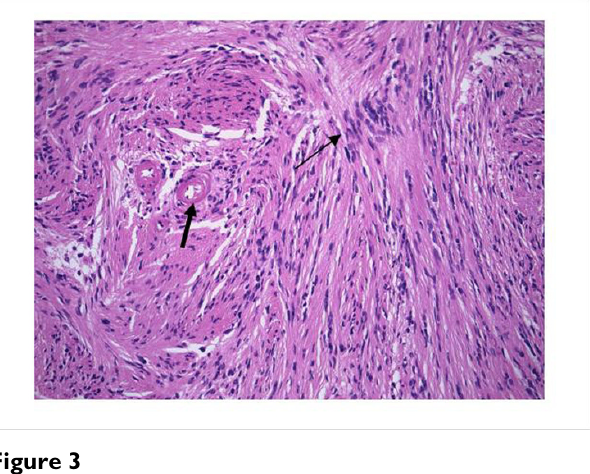
Figure 3 Low power view of schwannoma . Low power view of Schwannoma, illustrating the nuclear palisading (thin arrow) and the hyaline vessel walls (thick arrow). H&E stain,